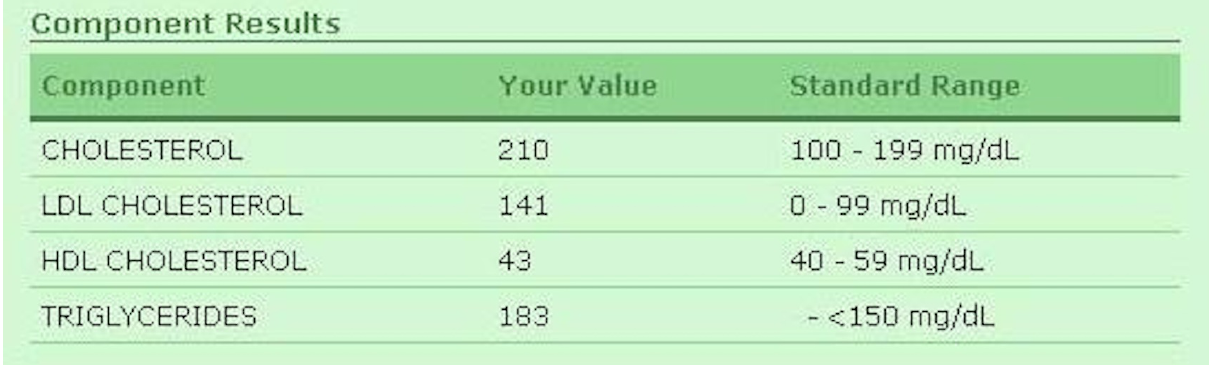
Figure 2. Sample cholesterol test result.